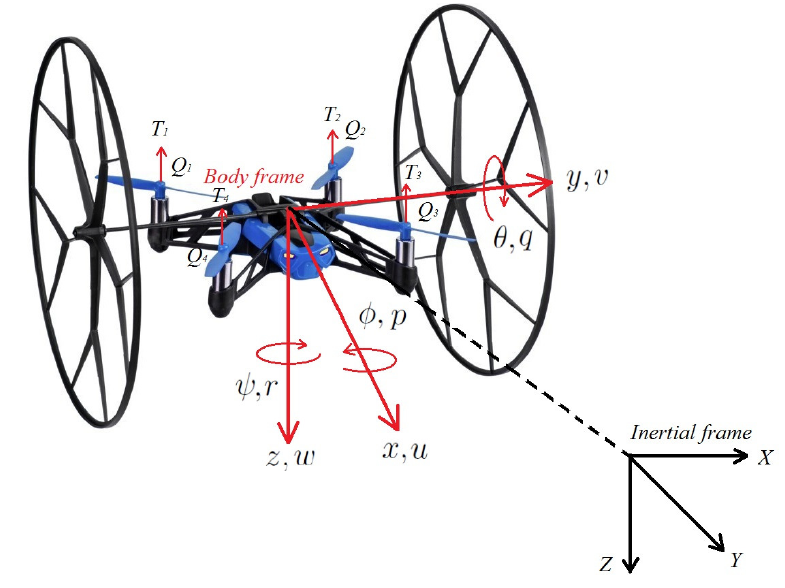
Figure 1. Referential frames’